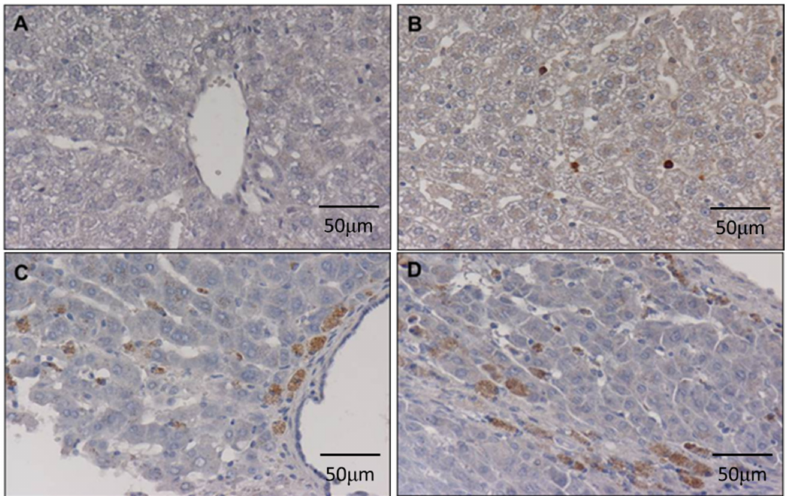
Figure 3. The immunohistochemical staining of OV-6 in hamster liver in week 7 ( n = 5), 27 ( n = 8), 33 ( n = 8), 50 ( n = 12): a score of 0 indicated no positive cells ( A ); a score of 1 indicated ≤ 5 stem cells in one high power field ( B ); a score of 2 indicated ≥ 5 and <10 stems cells in one power field ( C ); a score of 3 indicated >10 stem cells in one power field ( D ). Scores 0 and 1 were considered low-level expression, whereas scores 3 and 4 were considered high-level